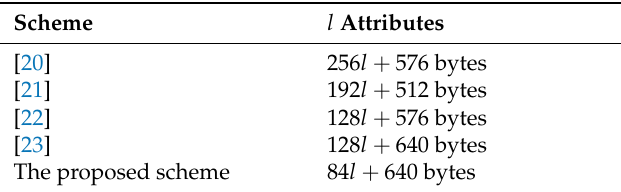
Table 4. Comparison of communication